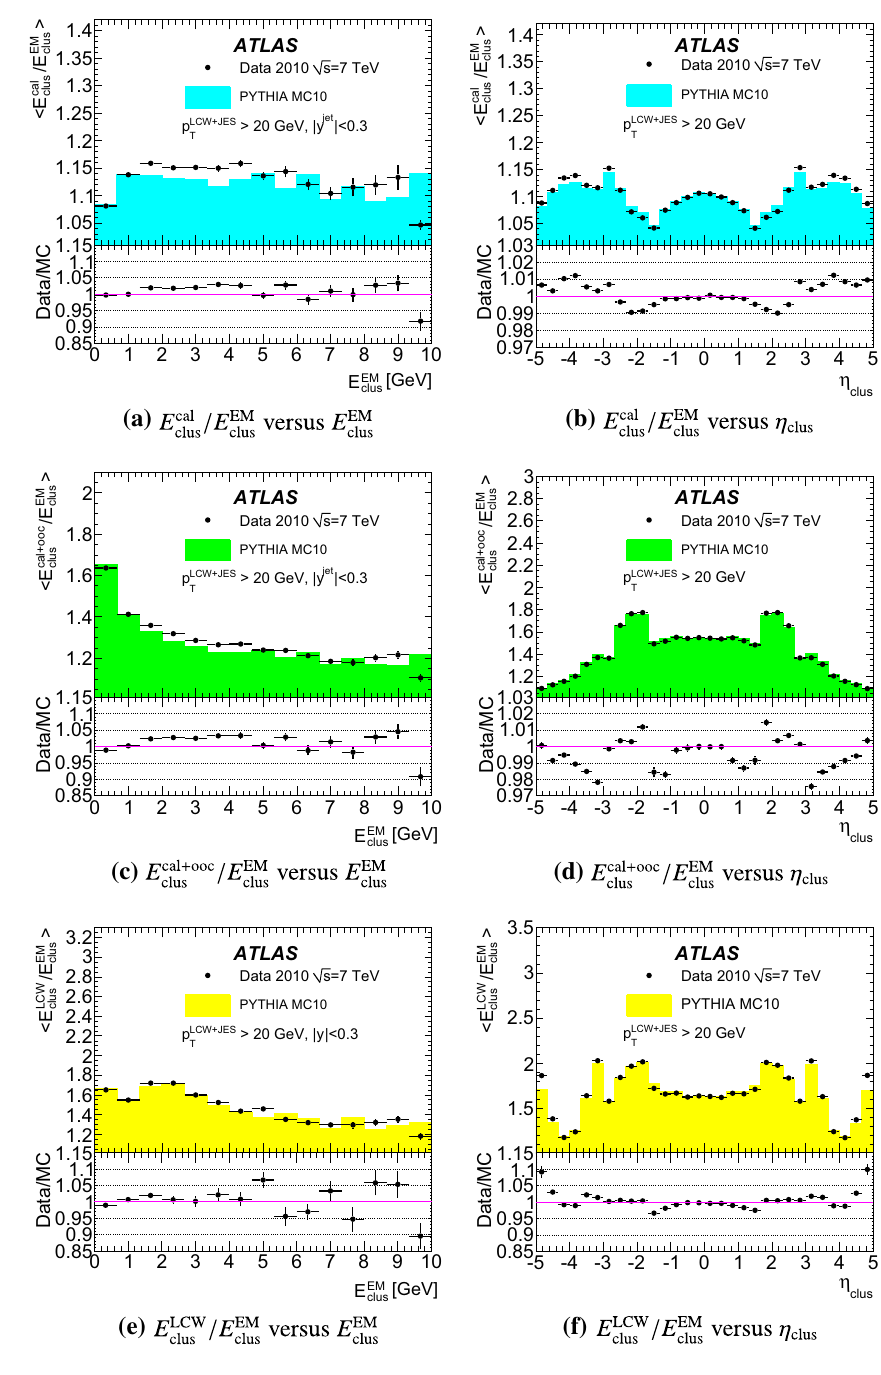
Fig. 18 The average ratio of reconstructed to EM-scale energy after each calibration step, as a function of the cluster energy E EM ( a , c , e ) for clus topo-clusters in anti- k t jets with R = 0 . 6 and p T > 20 GeV and with rapidities | y jet | < 0 . 3. The corresponding average ratios as a function of η clus are shown in b , d , and f . Data recorded in 2010 is compared to the corresponding MC simulations. The figures are adapted from Ref.